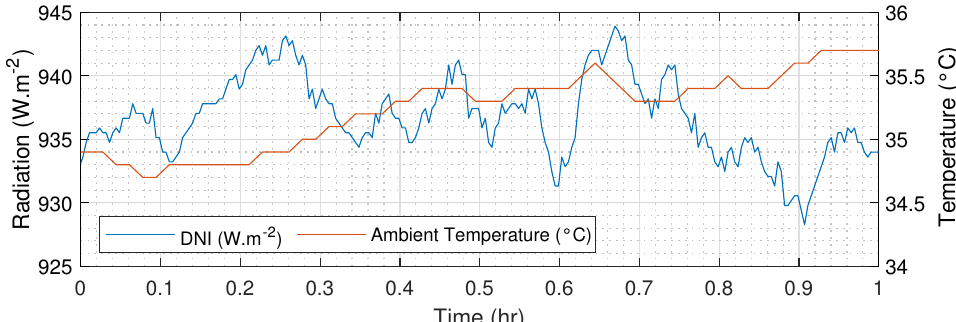
Figure 12. Weather conditions on the 8 August 2019 at 11 a.m.